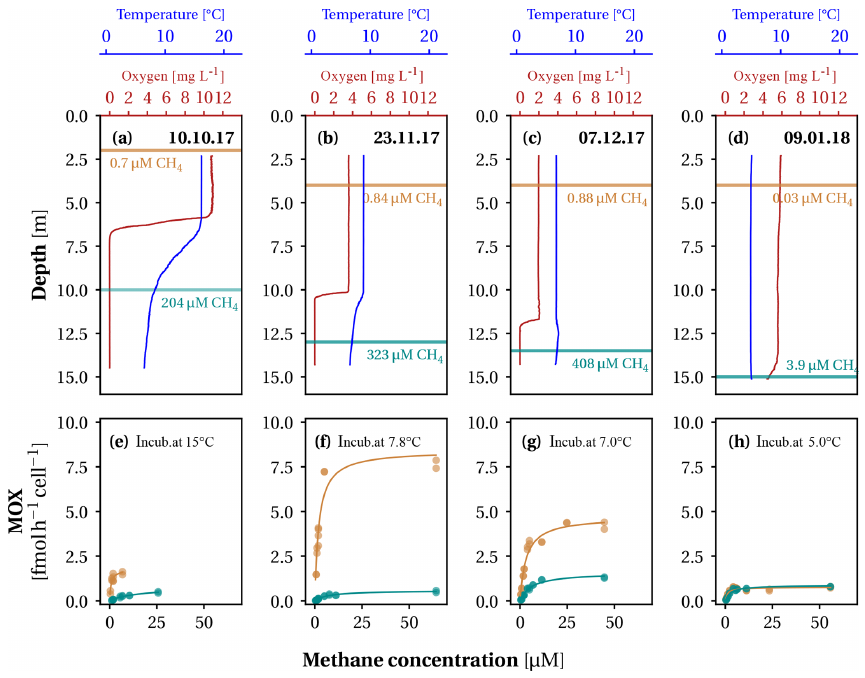
Figure 1. Substrate concentrations and apparent methane oxidation kinetics during lake overturn in Lake Rotsee. (a–d) Oxygen concentration and temperature profiles during the four field campaigns on the dates indicated. The sampling depths above (orange) and below (cyan) the oxycline are indicated by a horizontal bar. Numbers next to the bars represent methane concentrations (in µM) at the respective depths. (e–h) Cell-specific methane oxidation rates (MOX) of water samples incubated with different methane concentrations. Lines indicate the least-squares fits of the Monod kinetics. For each campaign, we incubated samples from both depths close to in situ temperature, given next to the annotation (“incub.” stands for